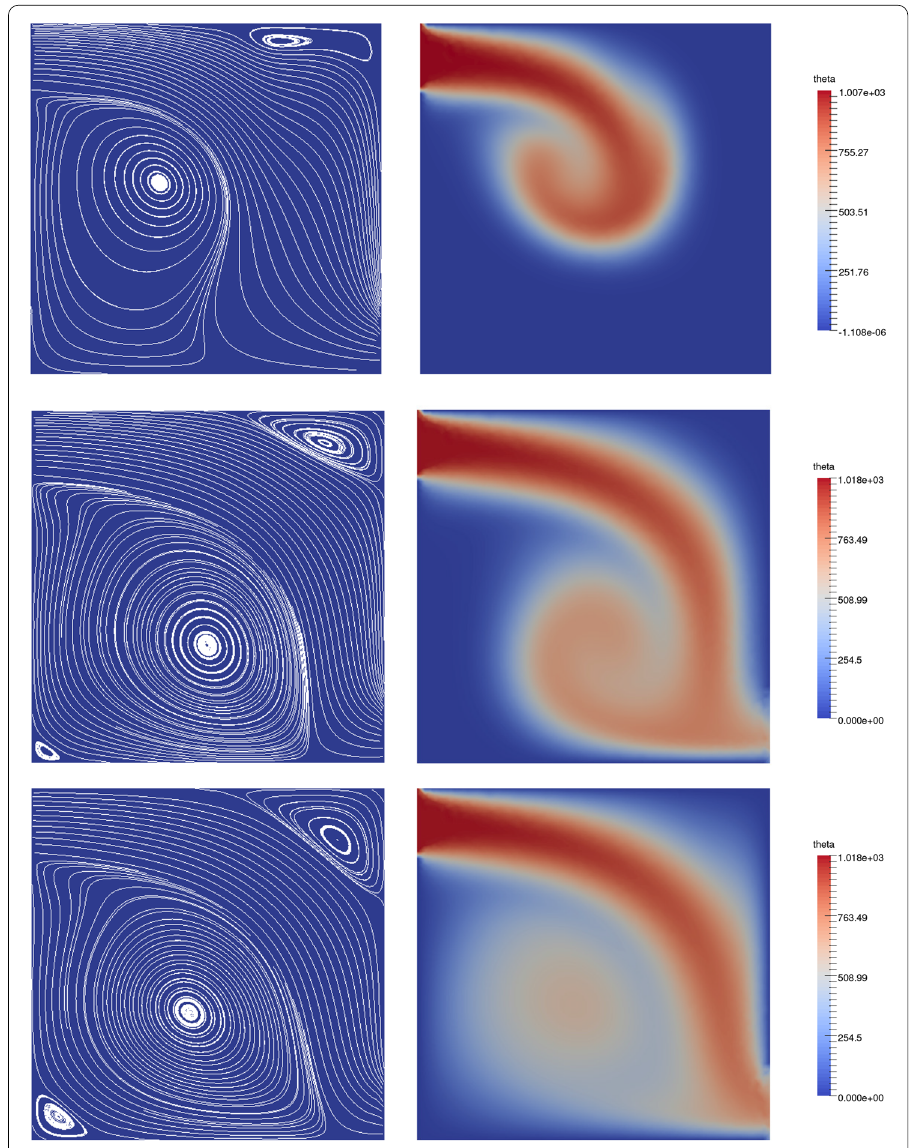
Fig. 37 Velocity streamlines (left) and repartition of polluant (right), at, from top to bottom, t = 0 . 5 τ , t = τ and t = 2